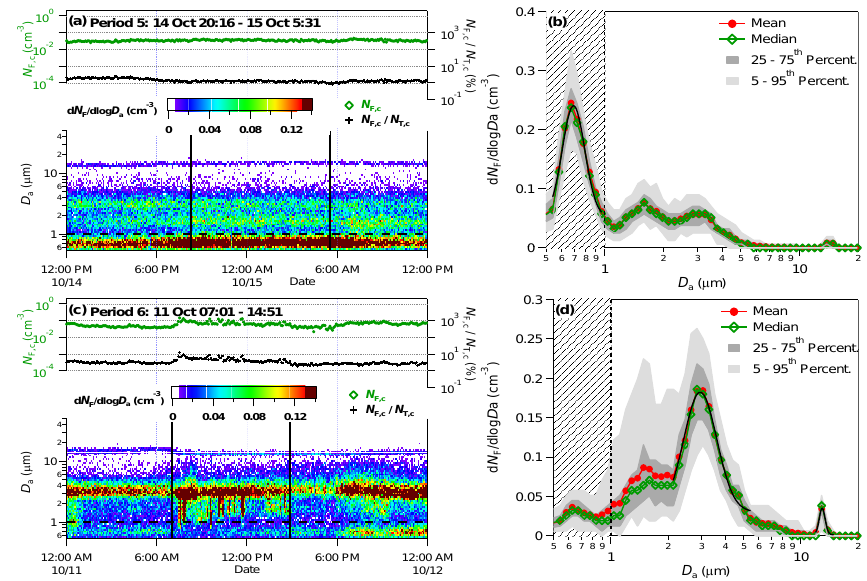
Fig. 9. Characteristic FBAP number size distribution patterns observed during exemplary periods #5 and #6 (plots analogous to Fig. 7). (a)–(b) Period #5; Fit 5.1: D a =0.54–0.96µm; D a , g =0.74µm, σ g =1.14, N =2.7 × 10 − 1 cm − 3 ; (c)–(d) Period #6; Fit 6.1: D a =2.1–5.4µm; D a , g =3.0µm, σ g =1.22, N =3.3 × 10 − 2 cm − 3 ; Fit 6.2: D a =12.0–14.9µm; D a , g =13.0µm, σ g =1.04, N =1.30 × 10 − 3 cm − 3 .